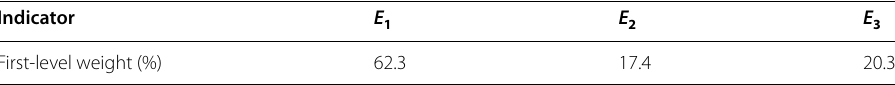
Table 4 Weights of indicators on the first level Indicator First-level weight